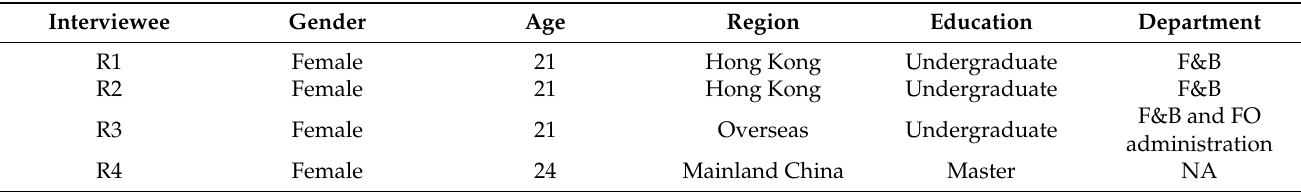
Table 2. Demographic information of